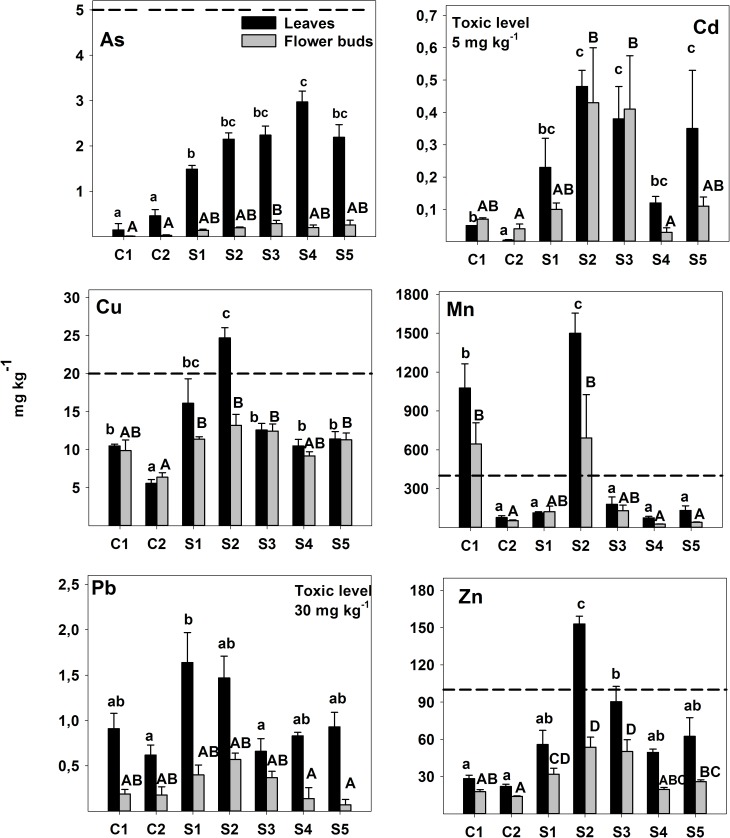
Trace element concentrations in E. camaldulensis leaves and flower buds (mean ± standard error).Significant differences (p < 0.05) among sites for leaves composition (black bars) are marked with lower case letter, while difference for flowers buds (grey bars) are in capital letters. As reference for TE, a dotted line indicates the lower limit of the range considered toxic for plants [59].